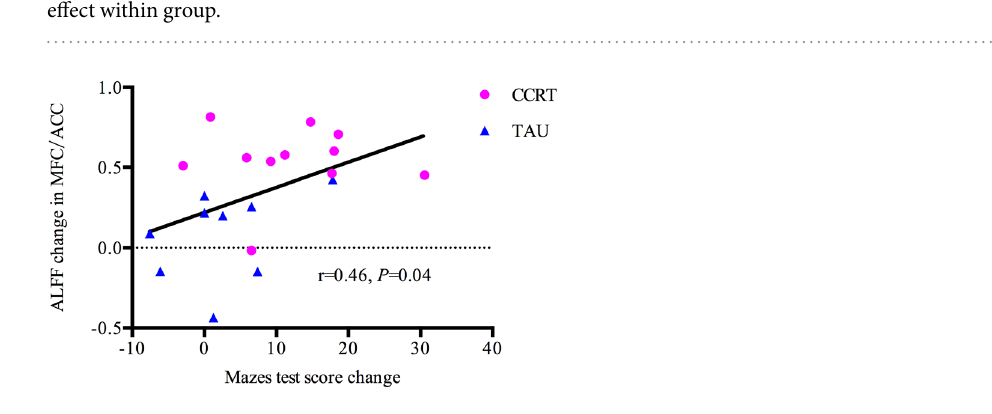
Figure 3. Amplitude of low-frequency fluctuation (ALFF) changes after CCRT. Paired t-test results in CCRT group were shown in Fig. 2A. And two areas shown significant interaction between group and time are plotted in Fig. 2B and C. The scatter plots of the two regions are also drawn (D and E). Note: in x axis of Fig. 2D and E, 1 = baseline, 2 = post-treatment. ★ Means significant group × time interaction, * means significant treatment effect within group.